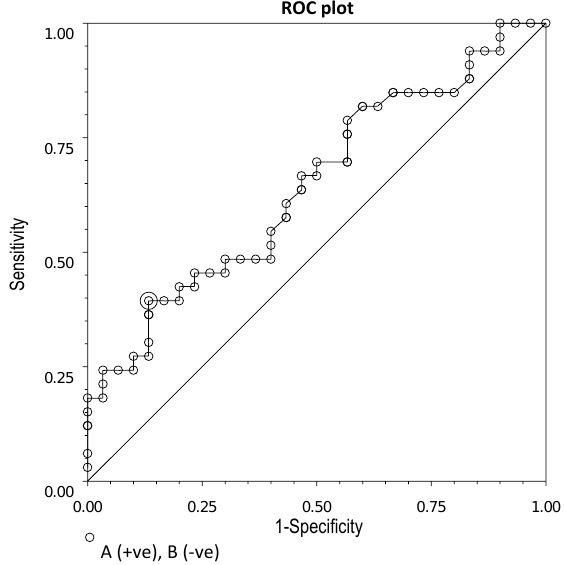
Figure 5. ROC plot for chemerin concentrations (cut-off point: 232.8 ng/mL; sensitivity: 0.39; specificity: 0.87; efficiency: 0.76).